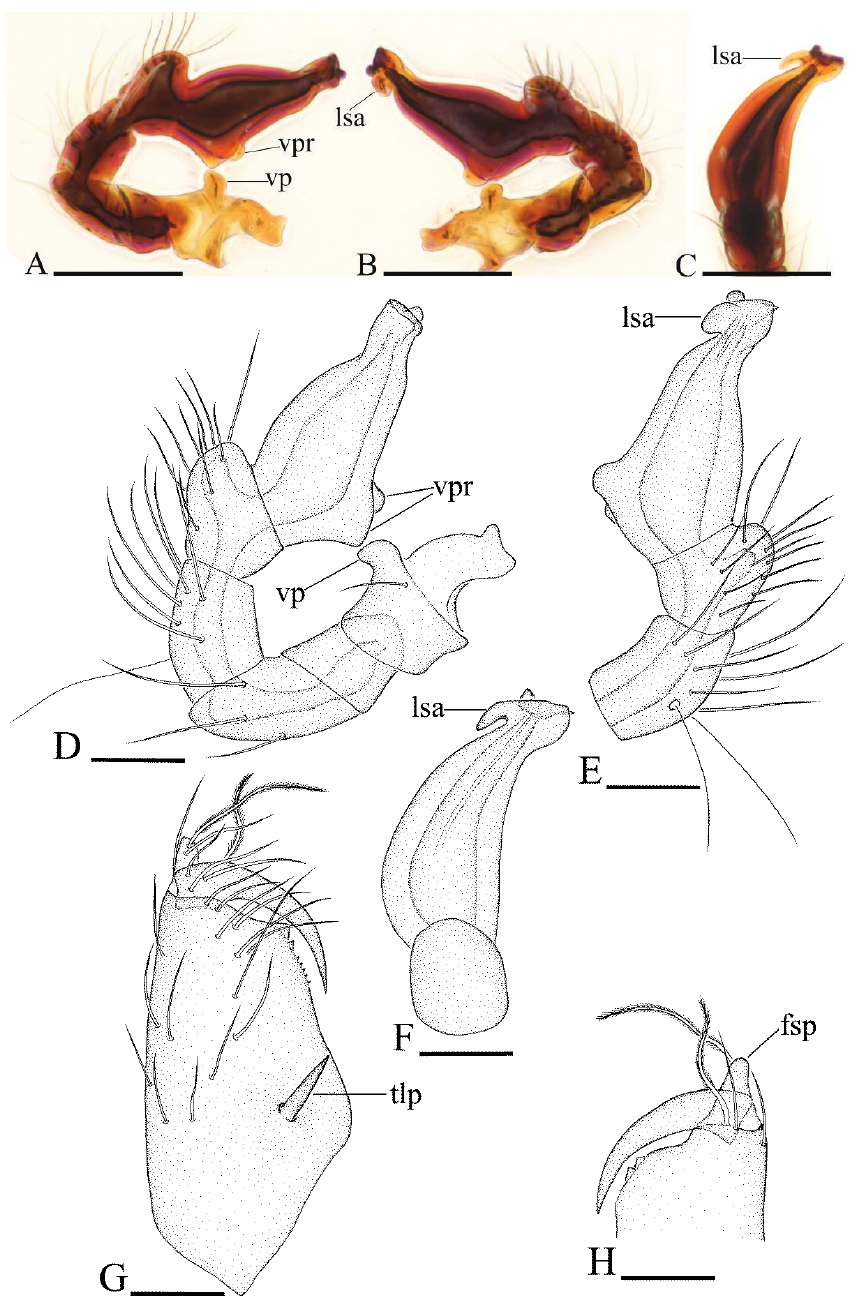
Figure 3. Ischnothyreus an sp. n., male. A, D left palp, prolateral view B, E left palp, retrolateral view C, F left palp, dorsal view G, H left chelicera, anterior and posterior views. Abbreviations: fsp = finger-shaped sclerotized process; lsa = leaf-shaped apophysis; tlp = thorn-like protrusion; vp = ventral projection; vpr = ventral protuberance. Scale bars: A–C = 0.1 mm; D–H = 0.05